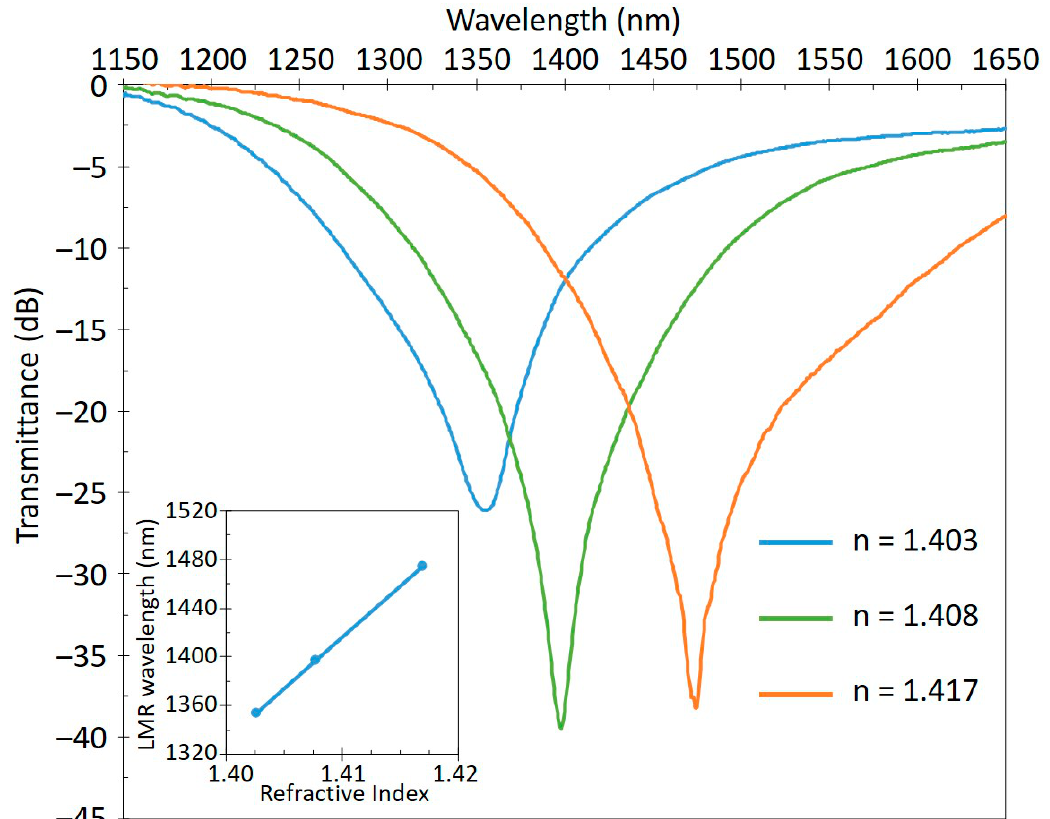
Figure 2. Example of the evolution of LMR for different surrounding media refractive index (SRI) values. The peak of the LMR shifts to longer wavelengths as the SRI increases. The inset shows a typical calibration curve, plotting the LMR position in function of the SRI, which characterizes the device as a refractometer.